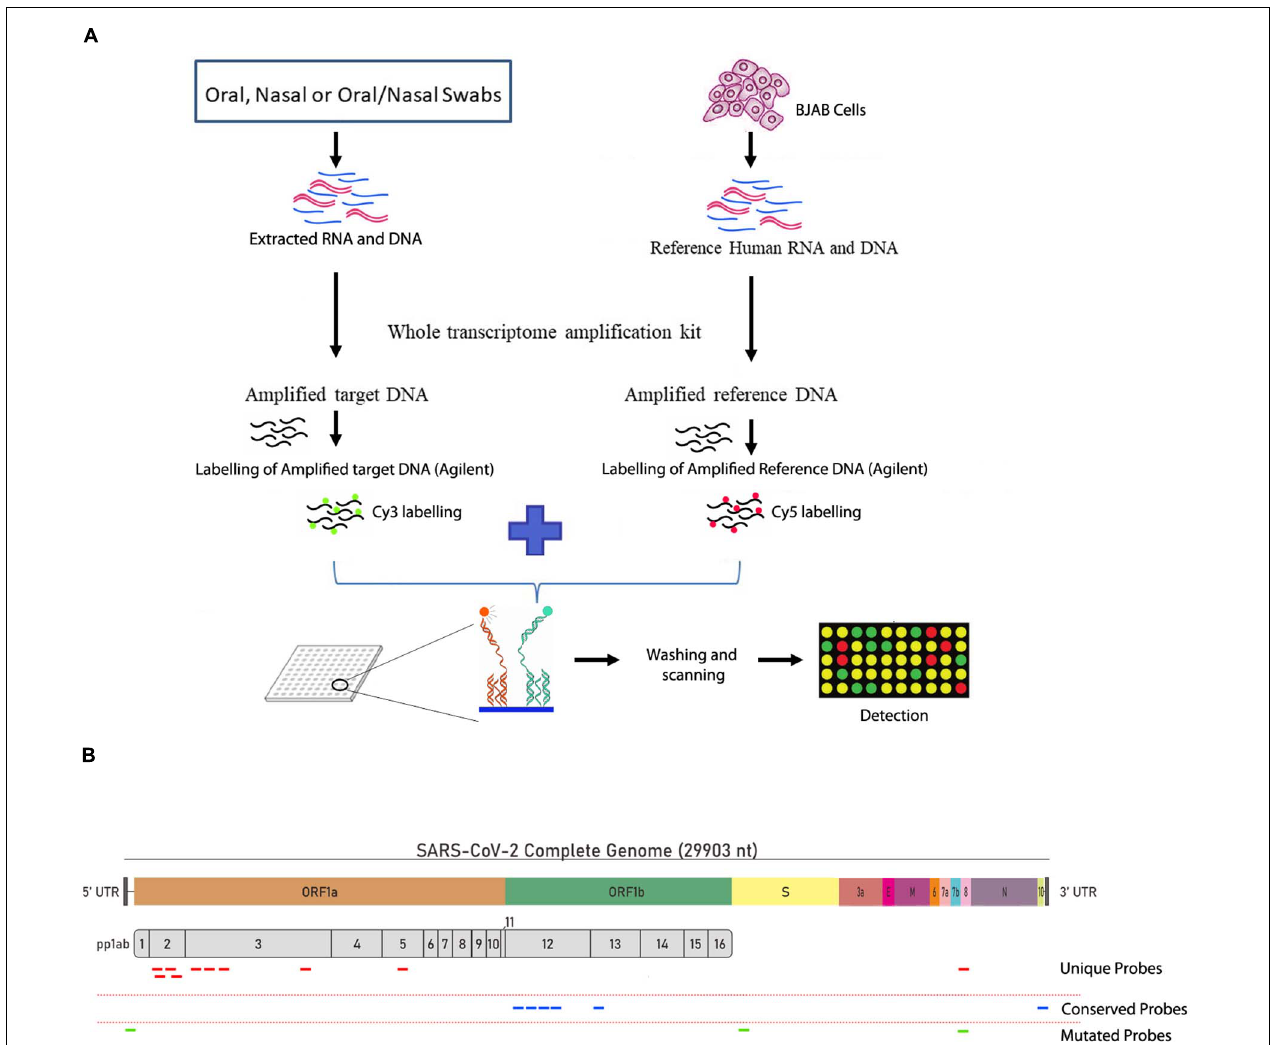
FIGURE 1 | Workflow of the PathoChip technology and the design of the viral probes. (A) Schematic diagram showing the simplified workflow of the PathoChip technology starting from sample collection to data acquisition. (B) The structure of the SARS-COV-2 genome and the position of the different unique, conserved and mutated 60 nucleotide probes used to identify the SARS-COV-2 viral